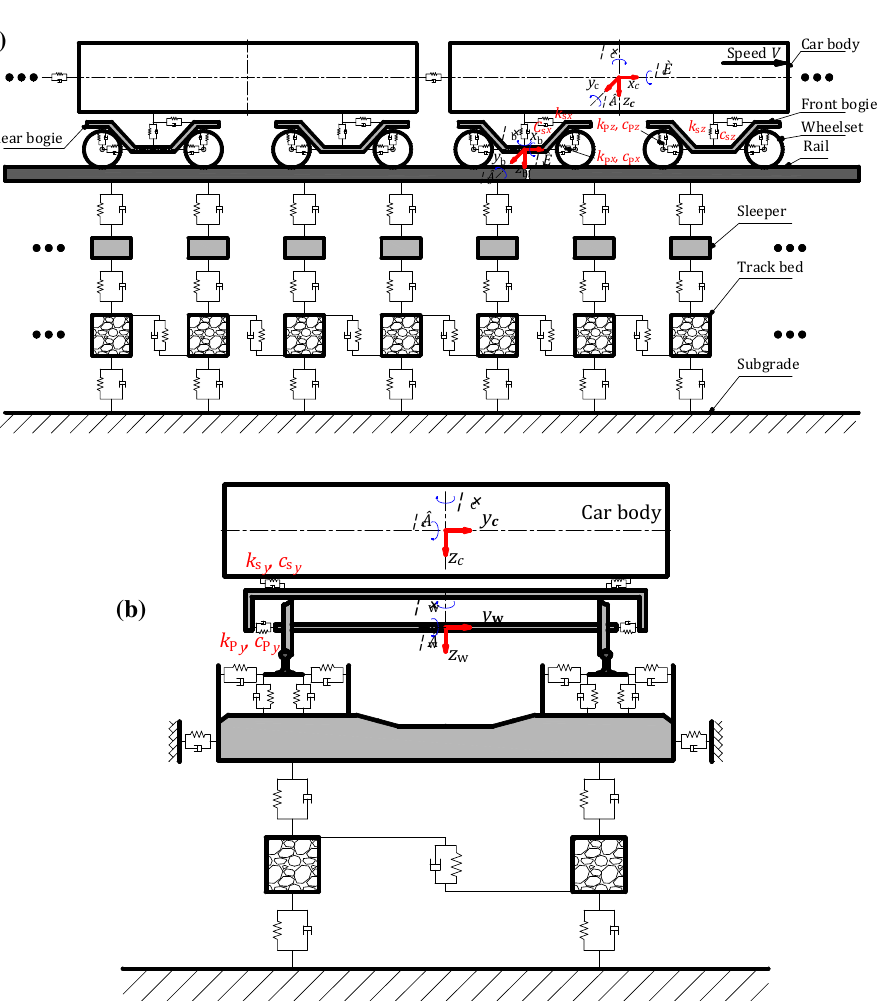
Fig. 1 Train–track interaction model ( a side view; b end view) (the symbols x , y , z , w , b and h denote the longitudinal, the lateral, the vertical, the yaw, the pitching and the rolling motion of the bodies, respectively; the subscripts ‘c’, ‘b’ and ‘w’ denote the car body, the bogie frame and the wheelset,